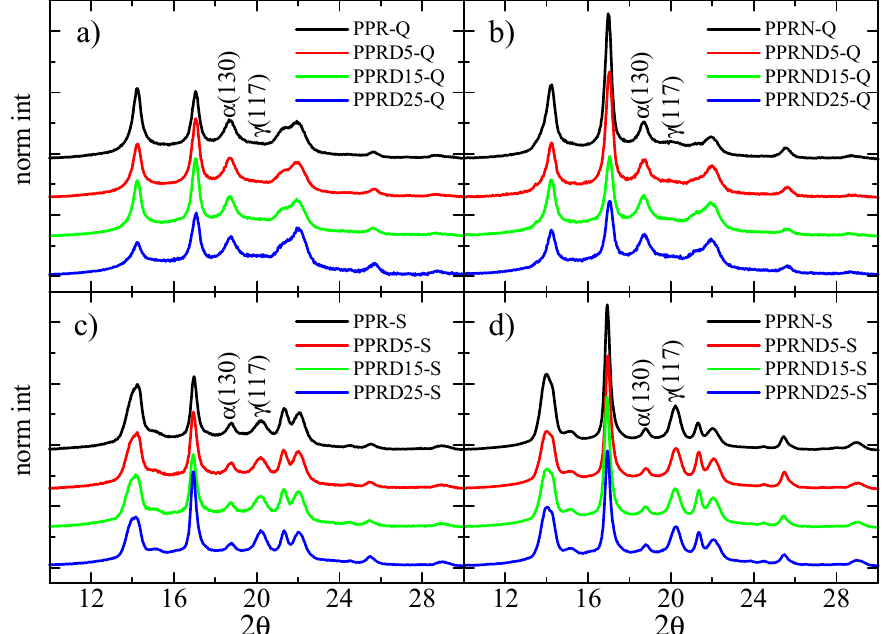
Figure 2. X-ray diffractograms for the different samples: ( a ) Q specimens; ( b ) PPR and PPRN samples; ( c ) S specimens; ( d ) PPR and PPRN samples. The curves are displaced vertically for clarity.